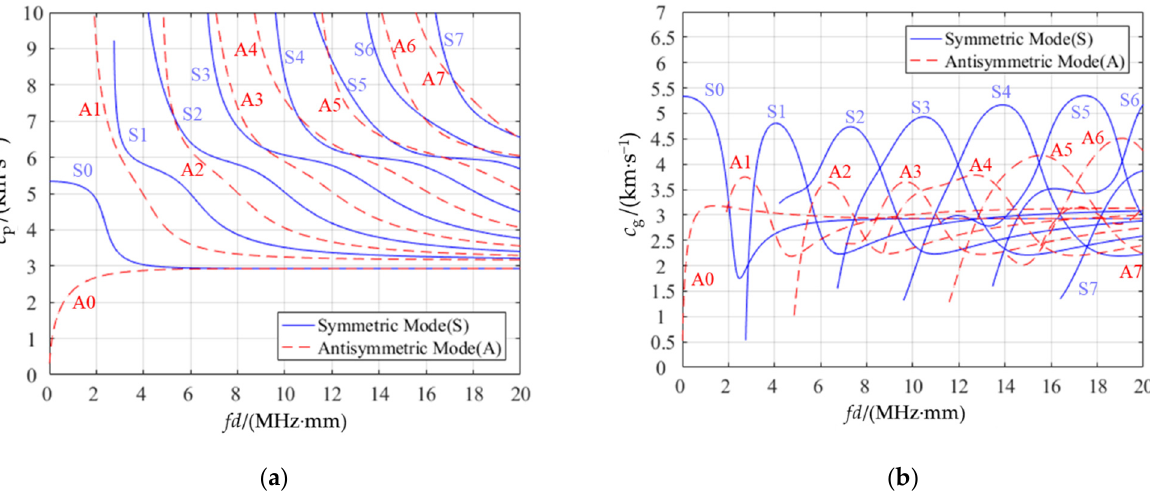
Figure 3. Dispersion curves of aluminum alloy: ( a ) phase velocity dispersion curve; ( b ) group velocity dispersion curve.